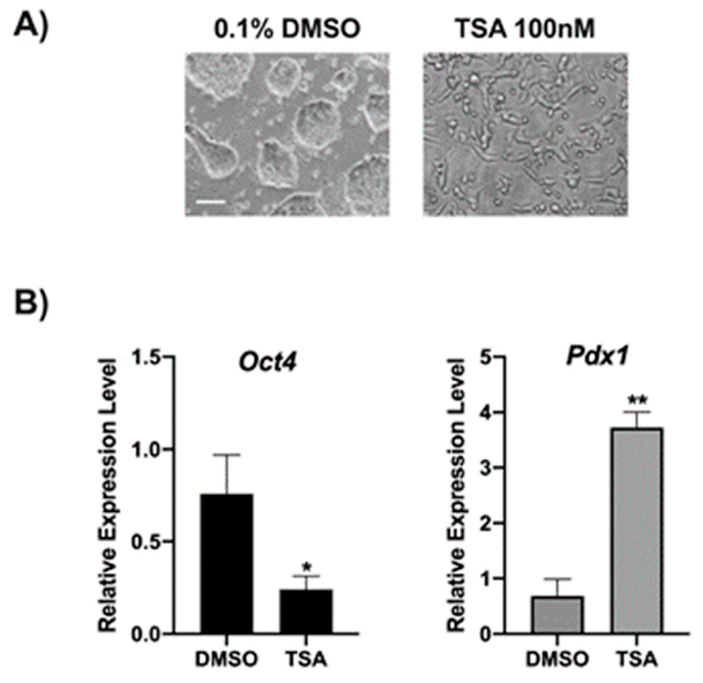
Figure 1. Trichostatin A (TSA) induces differentiation in ES14. ( A ) Phase-contrast microscopy analysis of ES14 cells following treatment with 0.1% DMSO or 100 nM TSA clearly showing morphology changes (scale bar, 100 µ m). ( B ) Gene expression analysis by qPCR for Oct4 (left panel) and Pdx1 (right panel) genes showing that incubation with TSA drives ES14 cells toward differentiation. Data points represent the average of triplicate determinations ± SD. Similar results were obtained in three independent experiments. * p < 0.05; ** p < 0.01.